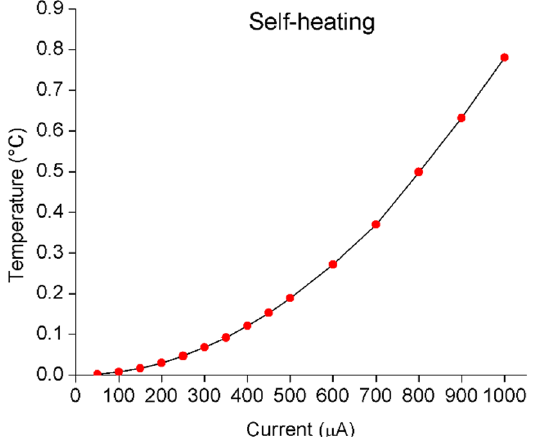
Figure 3. Simulated microsensor (24 windings) self-heating with respect to excitation current.